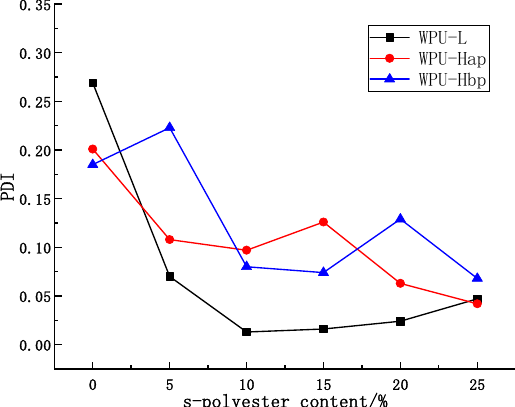
Figure 4. The polydispersity index (PDI) of the WPU-L, WPU-Hap, and WPU-Hdp emulsions.